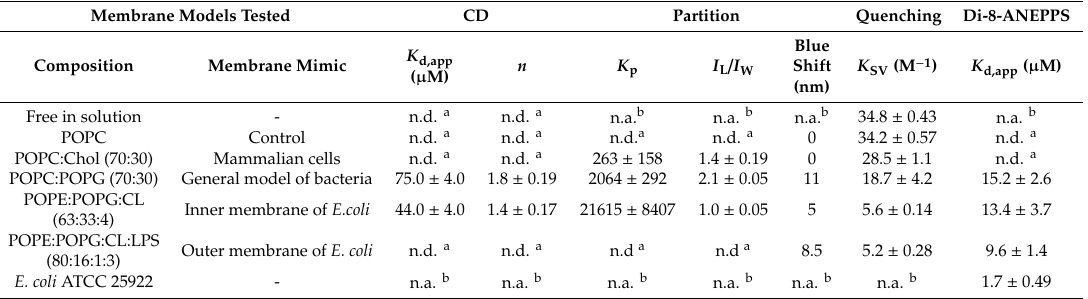
Table 2. Membrane selectivity parameters obtained and details of the lipid compositions of the systems